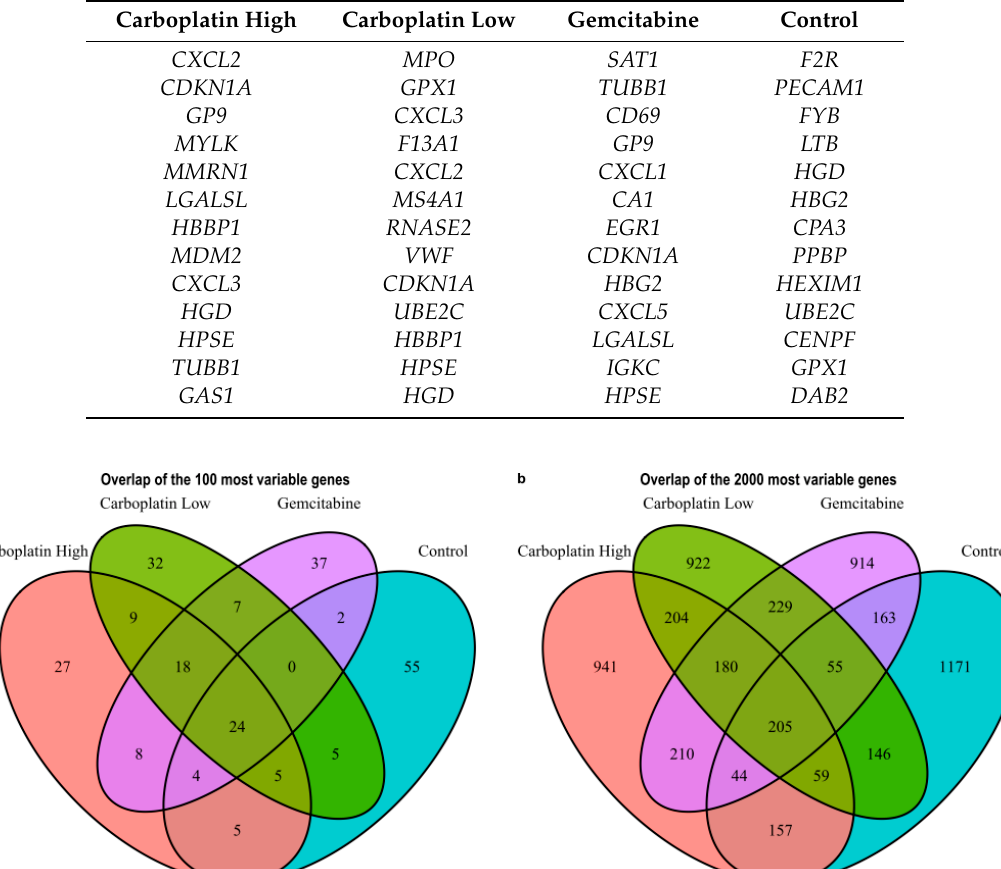
Figure 3. Venn diagrams showing the overlap between the treatment conditions Carboplatin High, Carboplatin Low, Gemcitabine, and Control. ( a ) The top 100 and ( b ) the top 2000 most variable genes.